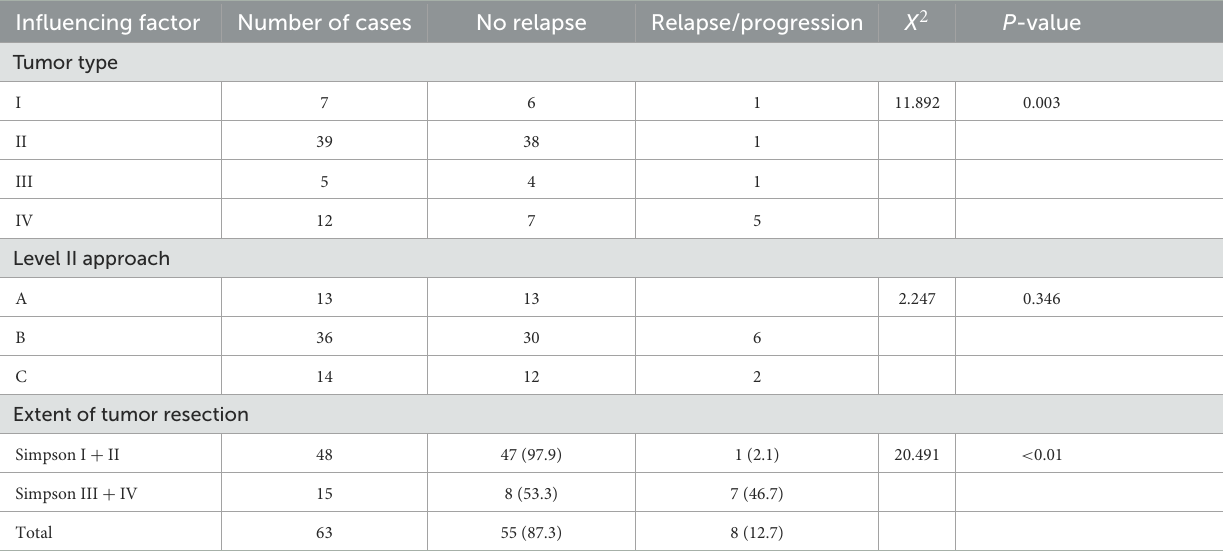
TABLE 7 Analysis of factors influencing postoperative relapse (case). Influencing